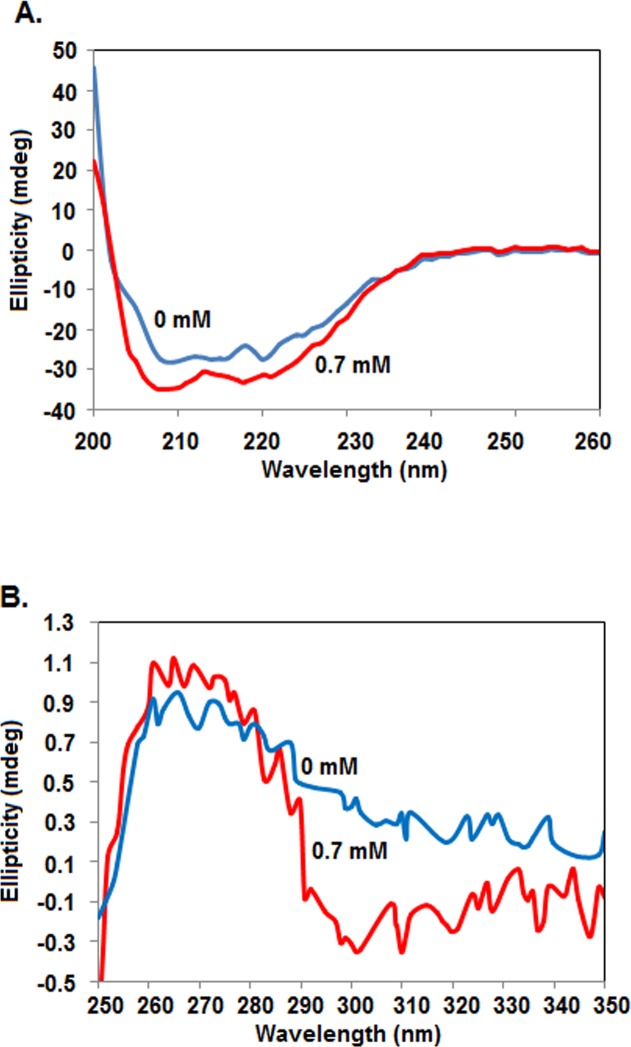
Secondary and tertiary structures of rSarA.Far-UV (A) and near-UV (B) CD spectra of rSarA in the presence of indicated concentrations of TX-100. All of the spectra are recorded at least three times. One set of spectra are shown here.